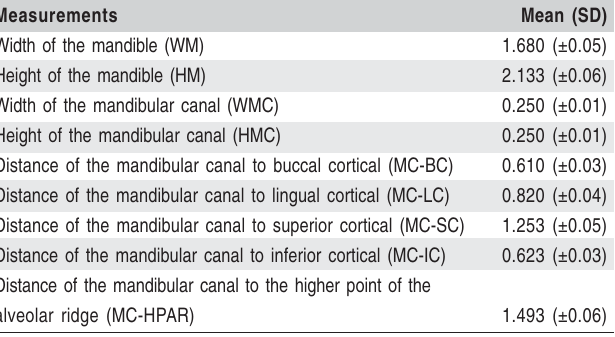
Table 2. Mean and SD of the measurements in MDCT images.